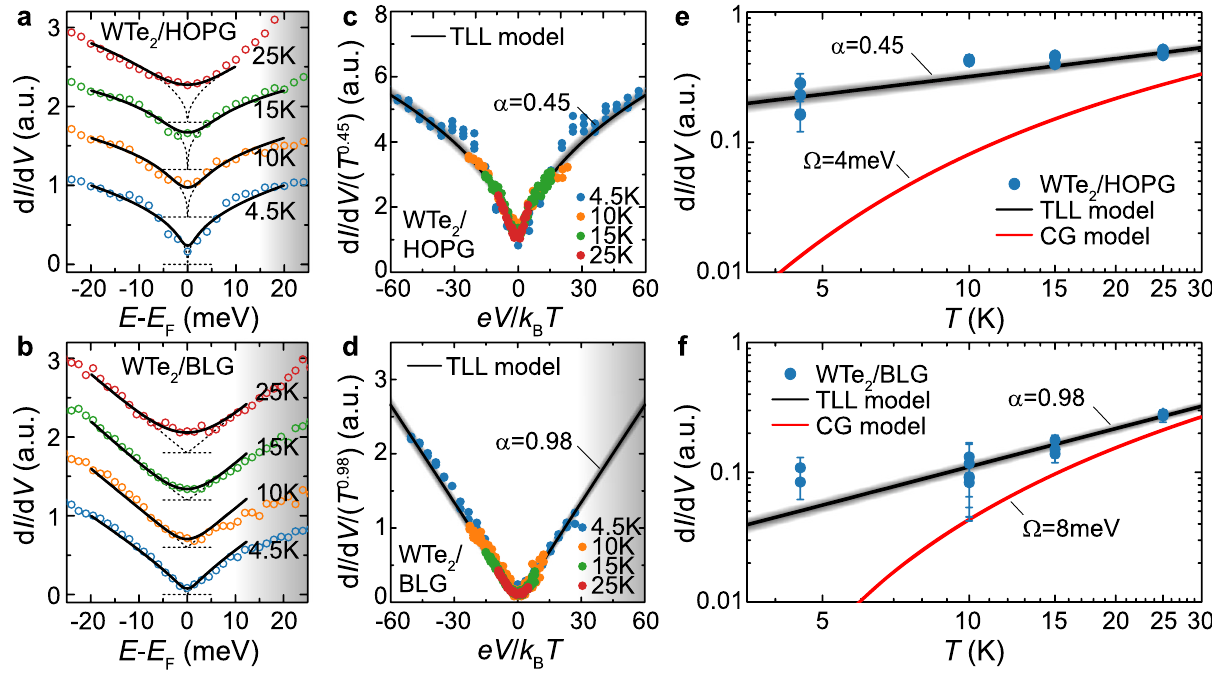
Fig. 2 | Demonstration of universal scaling for tunnelling into a Tomonaga- Luttinger Liquid (TLL). a , b Temperature dependent point spectra of the edge state ’ s local density of states (LDOS) up to T =25 K, measured at the Y-edges off WTe 2 /HOPGandWTe 2 /BLG,respectively.Thetunnellingspectraareoffsetby0.6on the y -axis with the zero position highlighted by horizontal dashed lines. Solid black lines are fi ts to TLL theory, taking into account thermal broadening (Section S3 of the Supplementary Information). The corresponding bare power-law fi ts are shown asdottedcurves.Theshadedbandsindicatetheconductionbandtail. c , d Thedata in a and b can be collapsed onto a single universal curve with common scaling exponents α =0.45 (WTe 2 /HOPG) and α =0.98 (WTe 2 /BLG). Shaded bands indicate